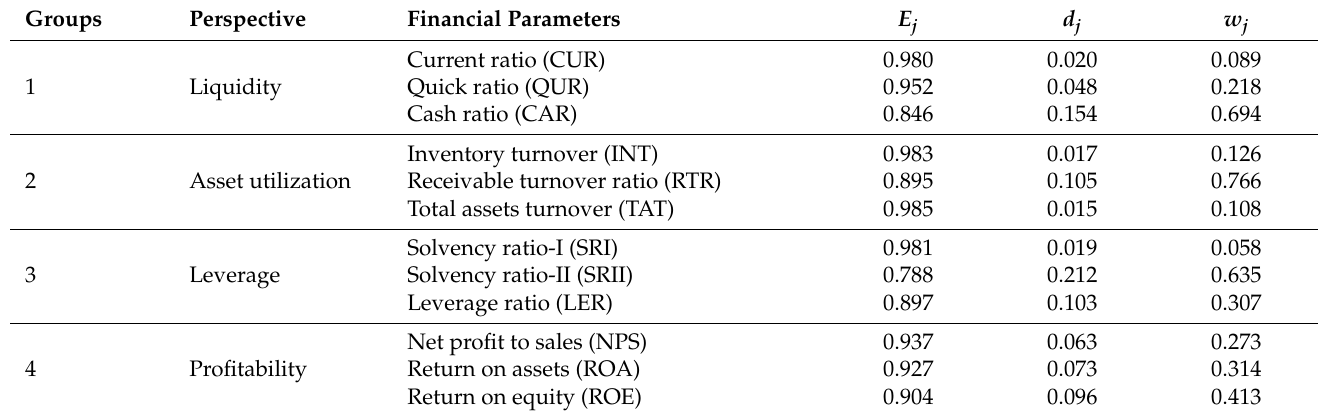
Table 1. Classification of financial indicators with Shannon entropy